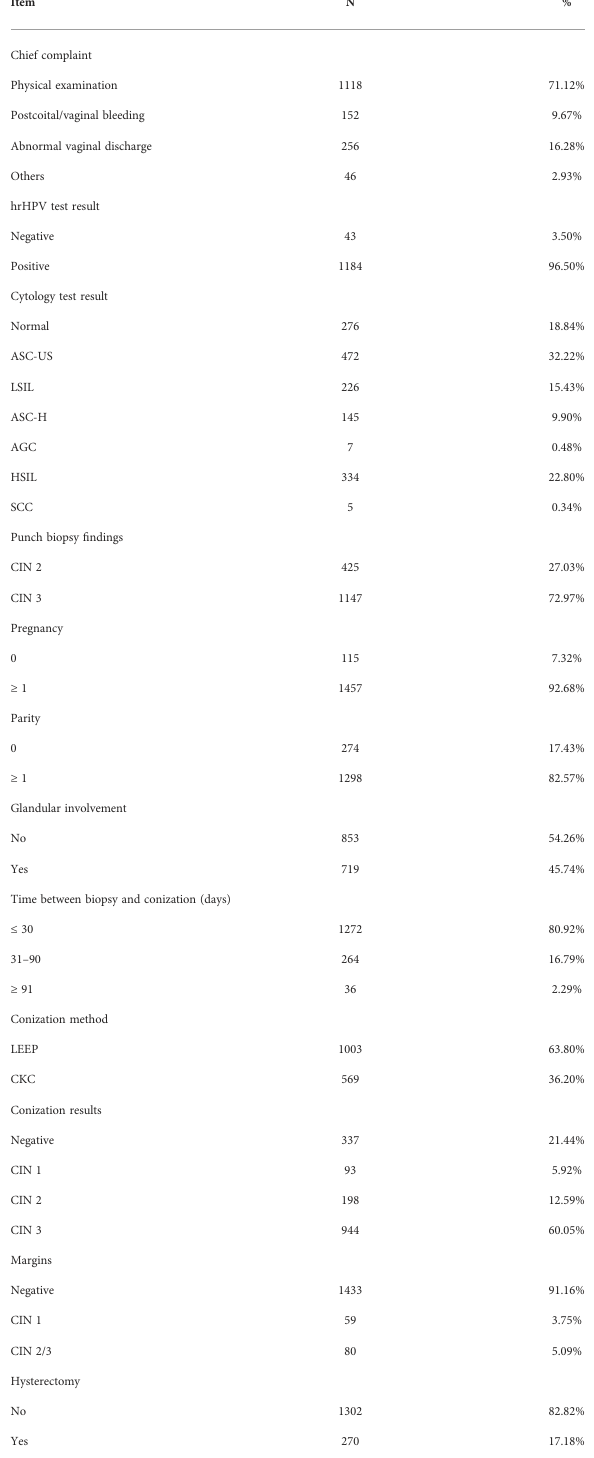
TABLE 1 Patient characteristics (N =